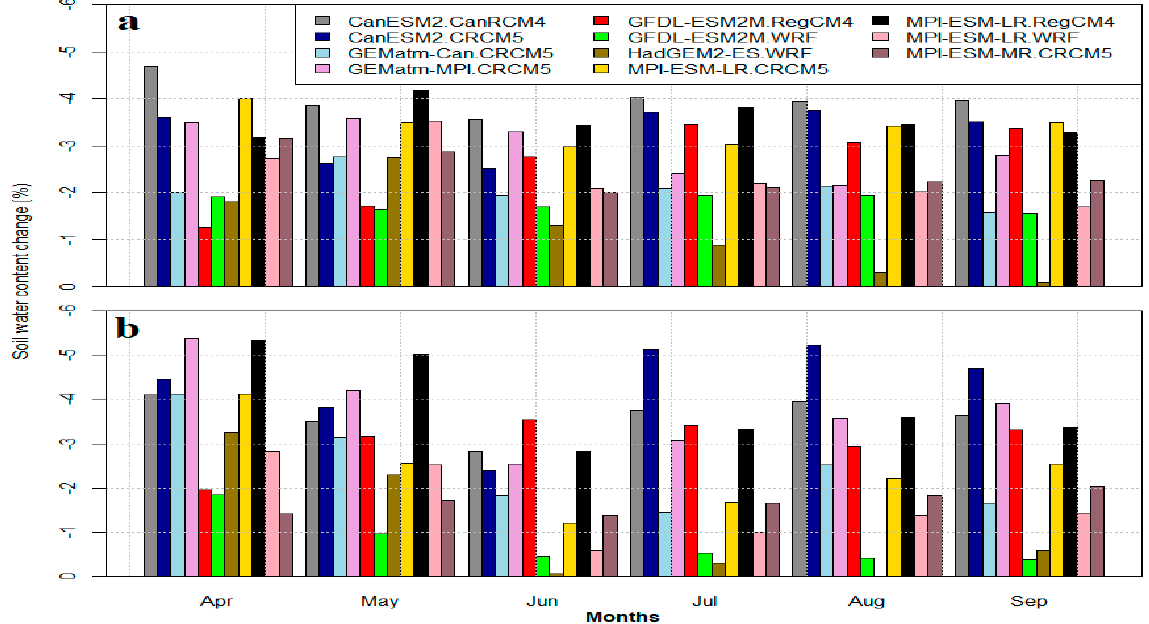
Figure 12. Monthly difference changes between ( a ) near future with historical and ( b ) distant future with historical.